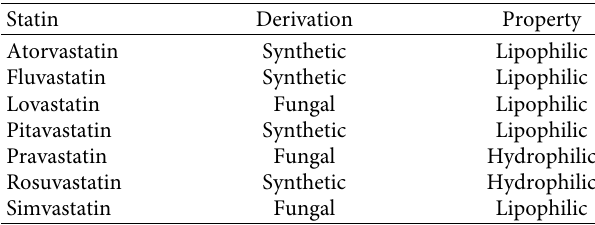
Figure 1: Study cohort. 128,161 KPSC members admitted to the hospital with sepsis from January 1, 2008, to September 20, 2018, were included in the analysis after the appropriate exclusion criteria were applied. Of this population, 34,088 patients were taking statins and 94,073 patients were not taking statins. Table 1: Pharmacological properties of